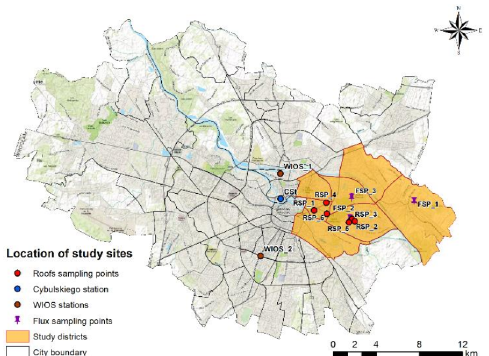
Figure 2. Location of study districts in the Wroclaw urban area. The measurement points are marked as: soil flux observation set/biogenic fluxes (violet pushpins), rooftop-level measurement sites (red points), location with on-site continuous diurnal series measurements (blue point); measurement stations operating by Inspectorate of Environmental Protection (dark red). The marks “RSP_1-6” indicate rooftop-level measurement sites, “FSP_1-3” soil flux sampling places, “CSt” means a location with continuous diurnal series measurements (“Cybulskiego station”), WIOS_1-2 are, respectively, measurement stations operating by Inspectorate of Environmental Protection. Base map source